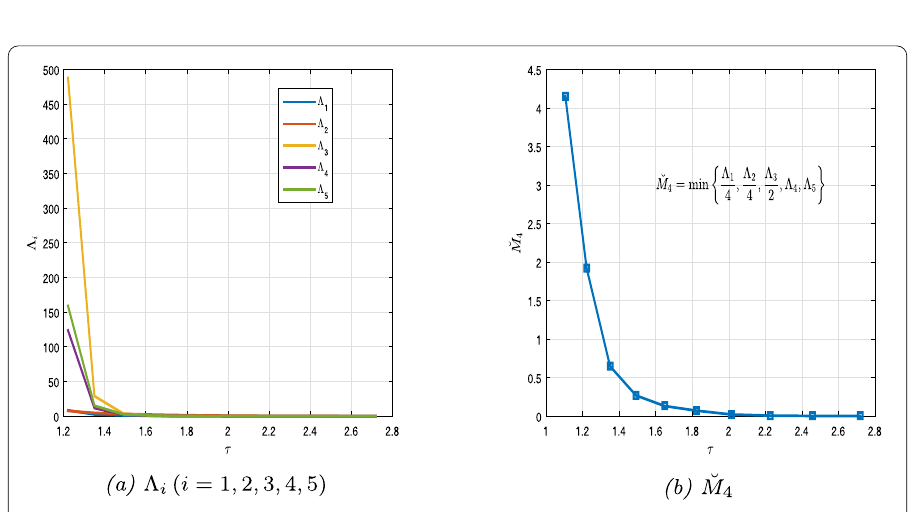
Figure 5 Graphical representation of (cid:19) i ( i = 1,2,3,4,5) and ˘ M 4 for τ ∈ J in Example